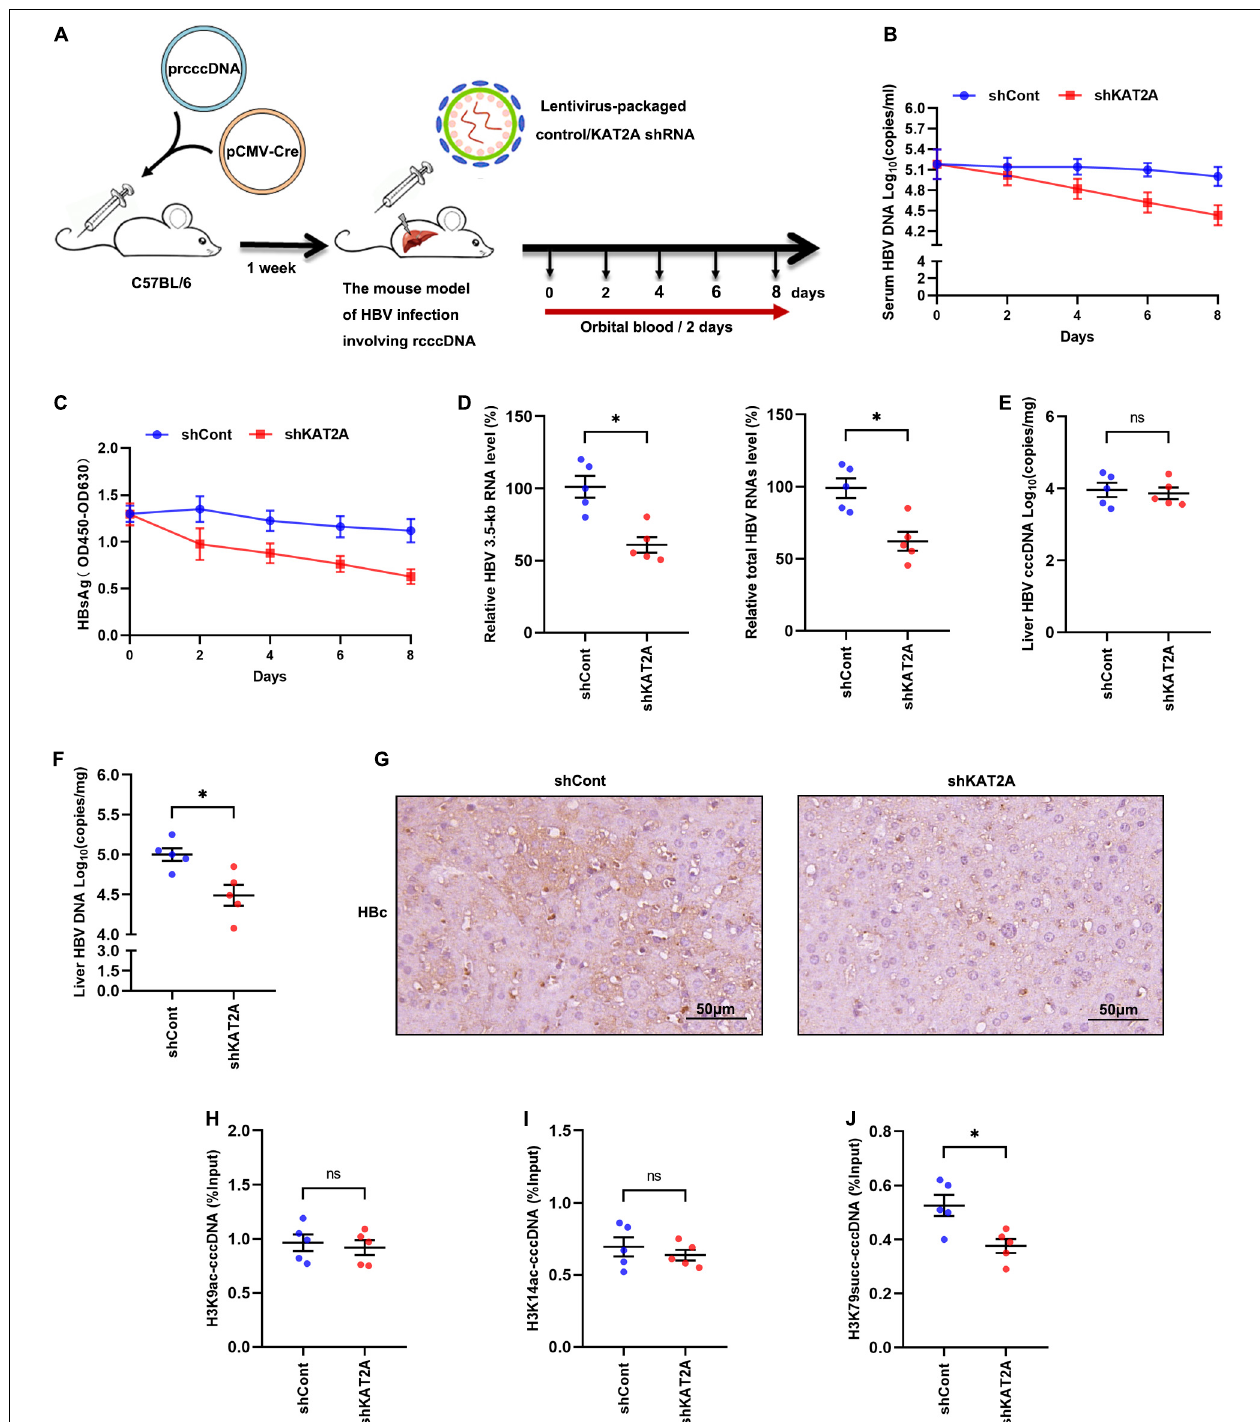
FIGURE 6 | Antiviral activity of KAT2A knockdown in vivo . (A) Schematic depiction of experiments in C57BL/6 mice. (B) Serum HBV DNA was detected by absolute quantification PCR. (C) Serum HBsAg was measured via ELISA. (D) HBV 3.5-kb RNA and total HBV RNAs in liver tissue were measured by real-time PCR. (E) HBV cccDNA in liver tissue was detected by Taq-man probe qPCR. (F) The level of HBV DNA in liver tissue was detected by absolute quantification PCR. (G) HBc in liver tissues was analysed by IHC. The scale bar is 50 µ m. (H,I) The levels of H3K9ac, H3K14ac associated with cccDNA were analysed by ChIP assay. (J) The level of H3K79succ associated with cccDNA was analysed by ChIP assay. * P < 0.05.